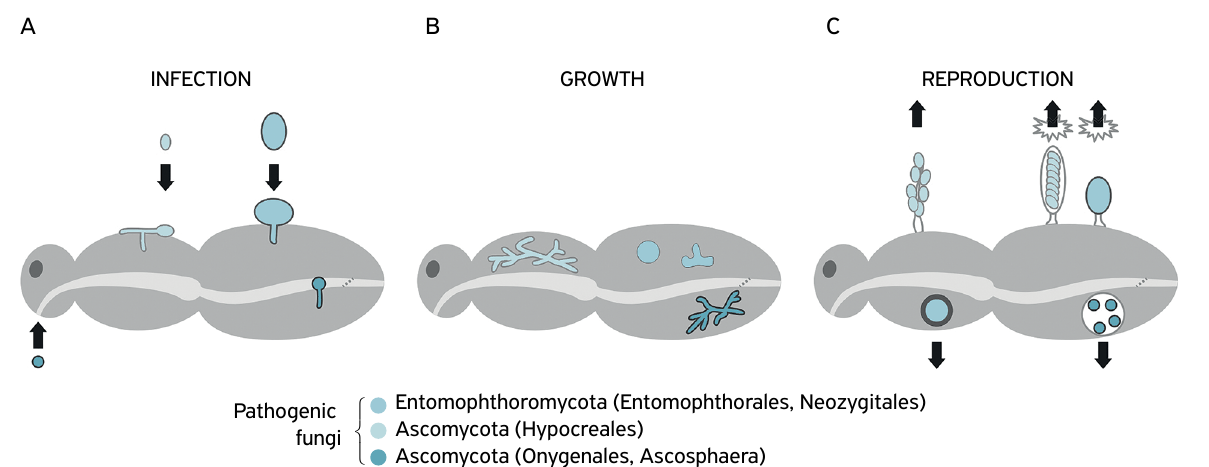
Entomophthoromycota (Entomophthorales, Neozygitales) Ascomycota Figure 2. The diagram illustrates the ways in which pathogenic fungi infect arthropod hosts by asexual or sex spores, proliferate and disperse. (A) Infection: Entomophthorales fungi infect mainly by large, sticky conidia that penetrate the cuticle directly, and Hypocreales fungi infect by small conidia, which produce appressorial structures. Ascosphaera spores are also small, enter orally, and infect through the gut epithelium. (B) Growth: most of Hypocreales and Onygenales proliferate through hyphal growth, and Entomophthorales fungi proliferate through protoplasts. (C) Reproduction: asexual conidia of Entomophthorales fungi and sexual ascospores of the Hypocreales are mainly forcibly discharged from the surface of cadavers (arrows upwards to the right), whereas (very large and thick-walled) sexual resting spores of Entomophthorales fungi and asexual conidia of Hypocreales are passively released (upward and downward arrows to the left). Ascosphaera produces only sexual spores that are passively released (downward arrow to the right) (BOOMSMA et al., 2014).